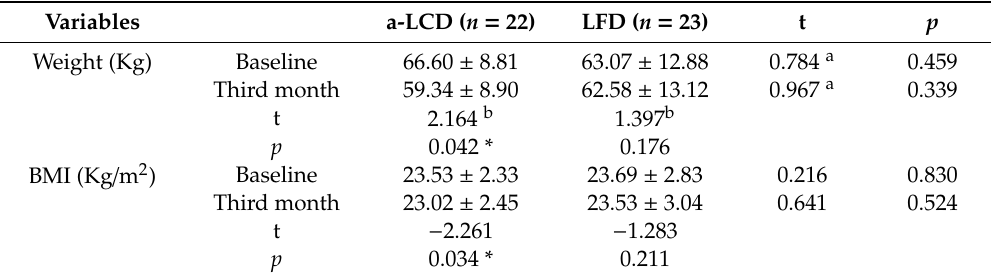
Table 5. Comparison of weight and BMI between the two groups.